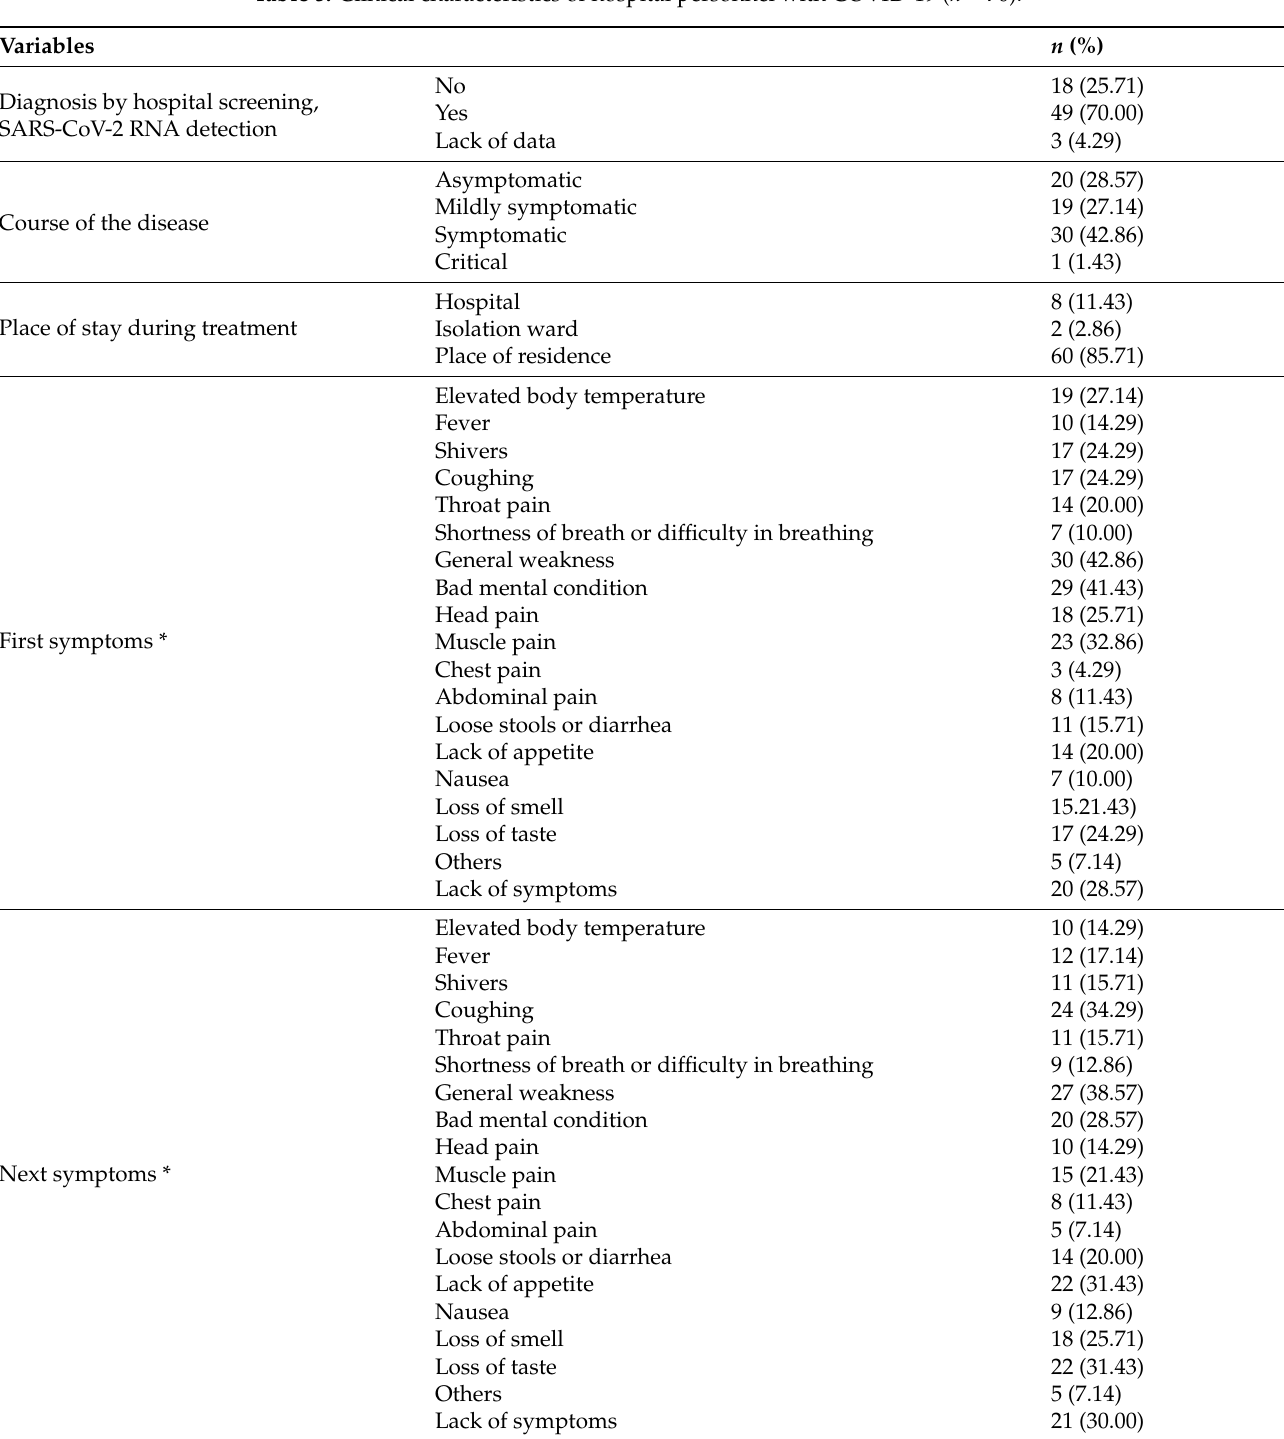
Table 5. Clinical characteristics of hospital personnel with COVID-19 ( n =